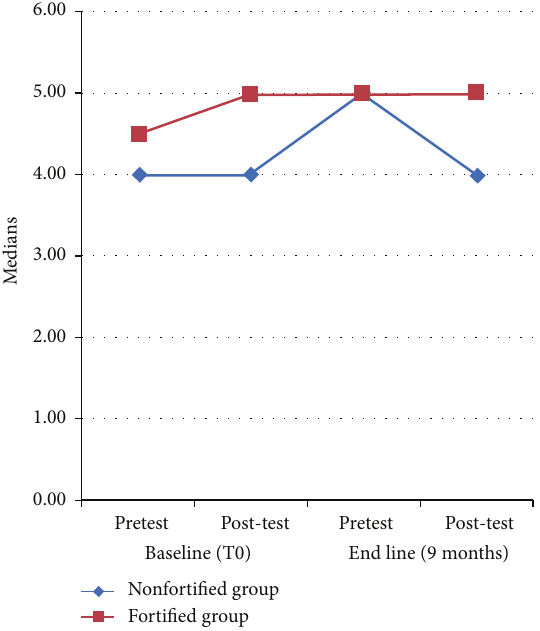
Figure 5: Comparison of cognitive test scores between the two studied